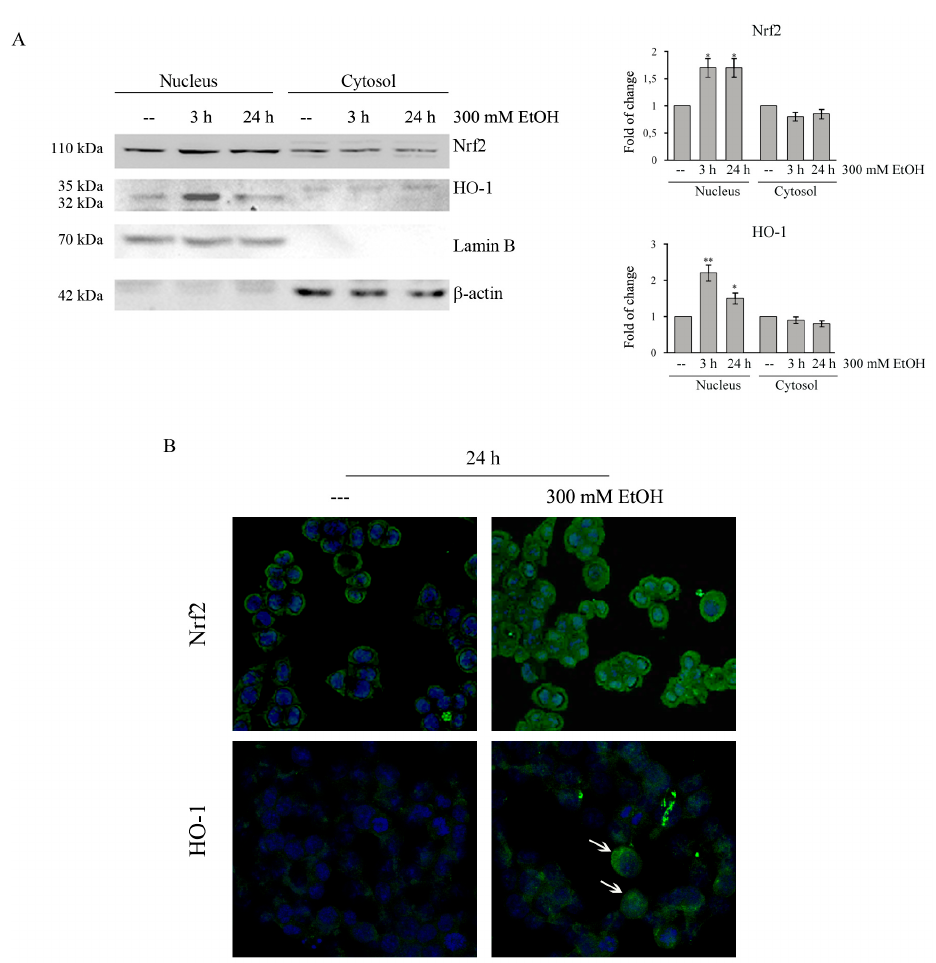
Figure 5. Ethanol induces the nuclear translocation of cytosolic Nrf2 and HO-1 in HCT116 cells. ( A ) Cells were treated for 3 h and 24 h with 300 mM EtOH. Equal amounts of nuclear or cytosolic proteins (30 µ g) were analyzed by Western blotting and quantified by densitometry for Nrf2 and HO-1 expression normalized against Lamin B and β -actin. Representative blots of three independent experiments are shown. (*) p < 0.05 and (**) p < 0.01 compared to the untreated sample. ( B ) HCT116 cells (8 × 10 3 ) were grown on coverslips and treated for 24 h with 300 mM EtOH. EtOH-induced nuclear translocation was observed under confocal microscope TCS SP8 employing Nrf2 or HO-1 specific antibodies followed by incubation with a fluorescein isothiocyanate (FITC) conjugated IgG secondary antibody (green). The cells were also stained with Hoechst (blue fluorescence) to visualize nuclear morphology. Original magnification: 400 × . The results are representative of three independent experiments.